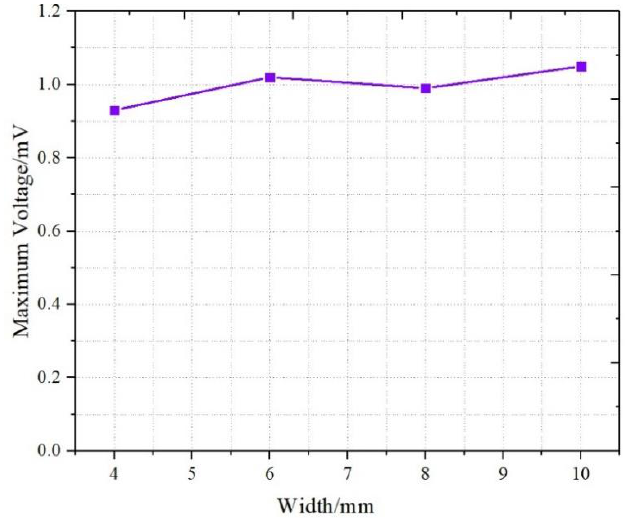
Figure 11. Signals of different widths.